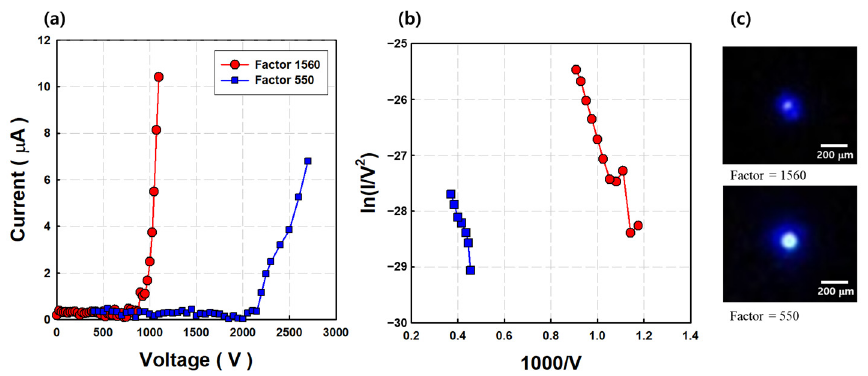
Figure 2. Comparison of field emission properties. ( a ) Field emission properties; ( b ) F–N plot; ( c ) captured image of field emission patterns on phosphor screen at 1 μ A of emission current.